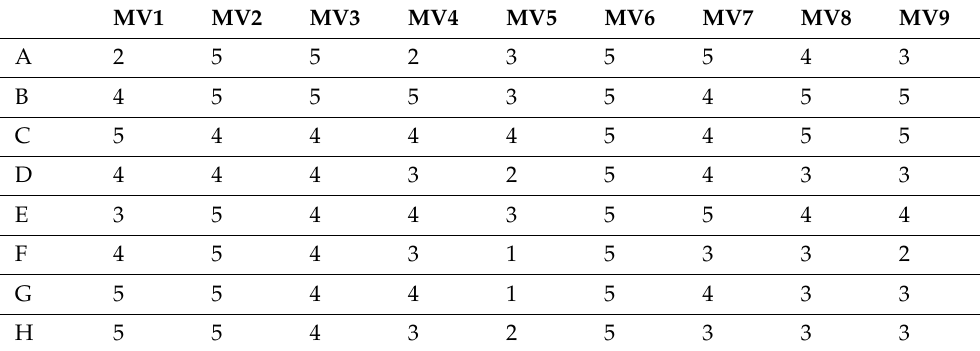
Table 2. The levels of mastery for the eight non-technical skills among the nine